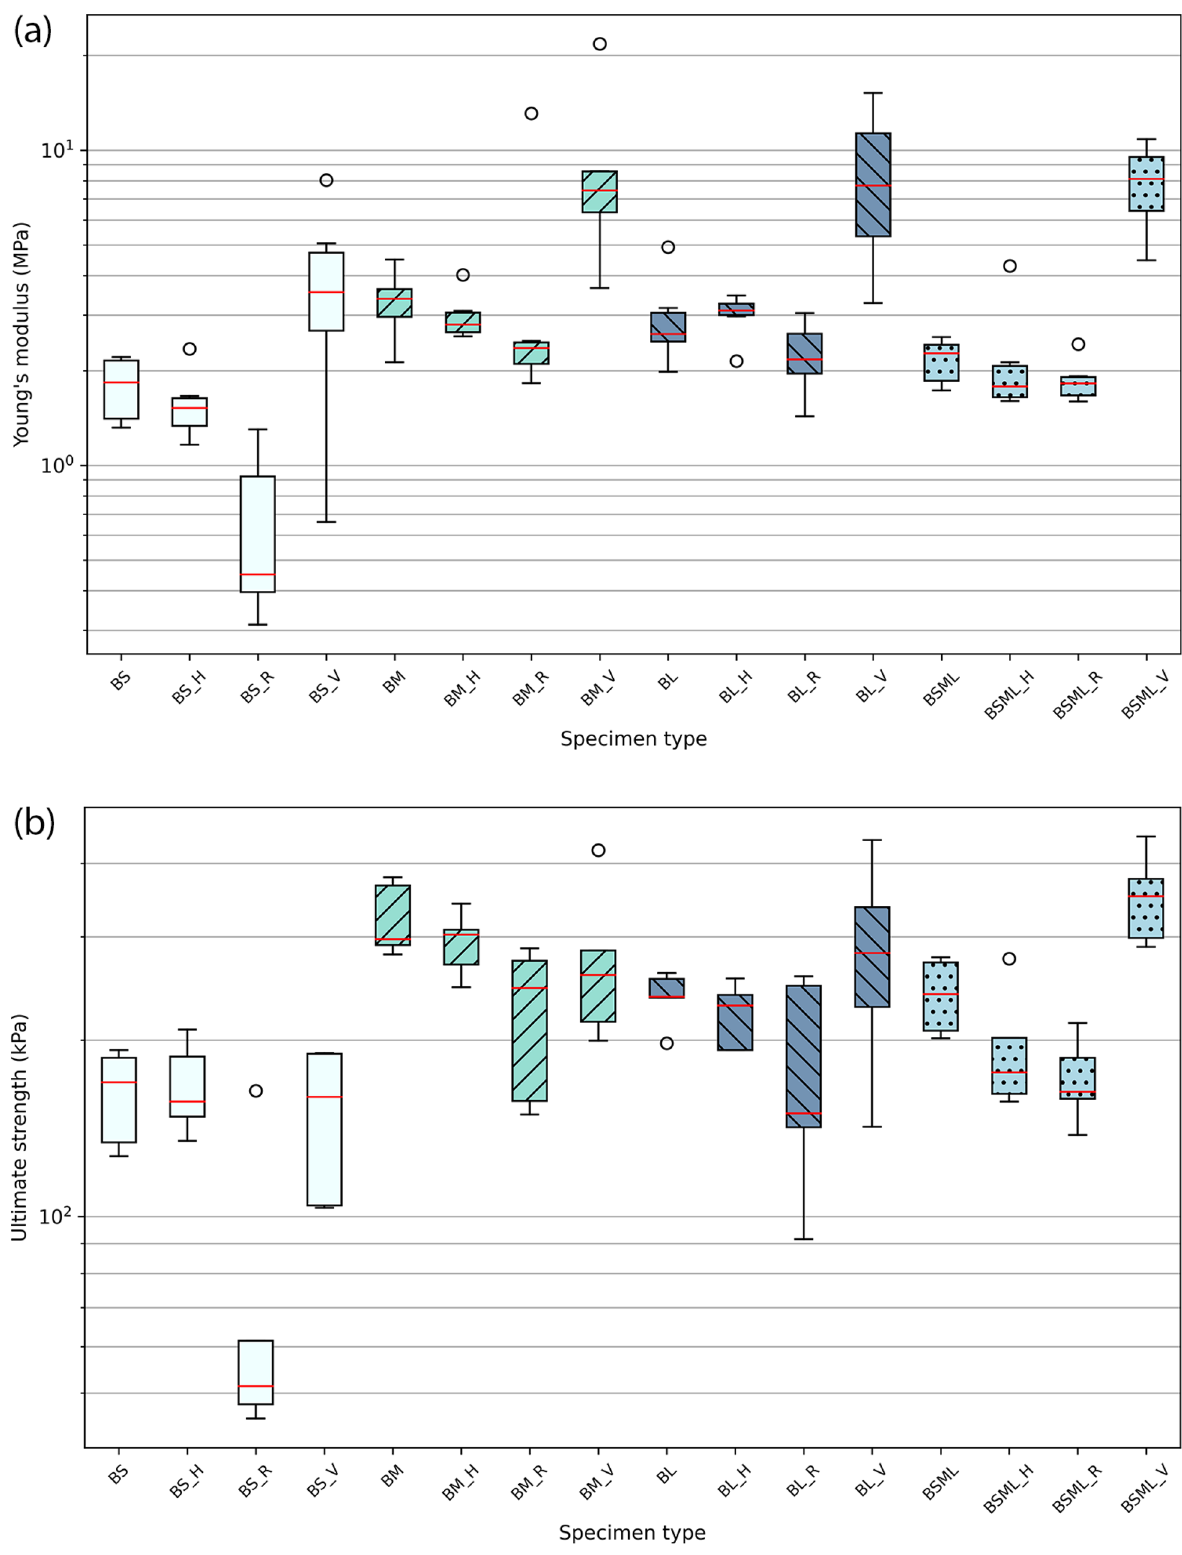
Figure 4. Box plots for Young’s modulus results ( a ) and ultimate strength results ( b